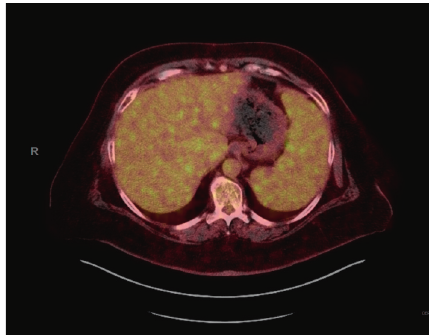
Figure 5: 5/2017 the previously described diffuse scattered foci of hypermetabolic activity within the liver have significantly im- proved. The previously described abnormal activity within the spleen is not visualized